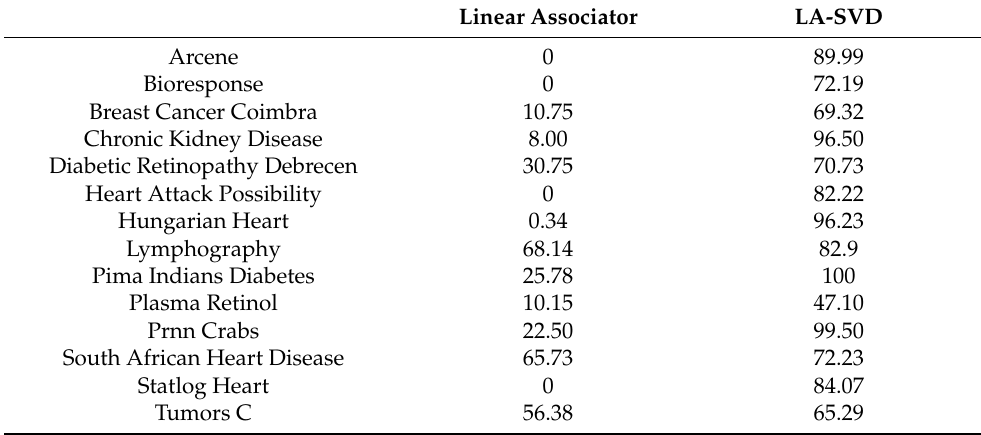
Table 11. Accuracy values (in %) exhibited by both classifiers: linear associator and